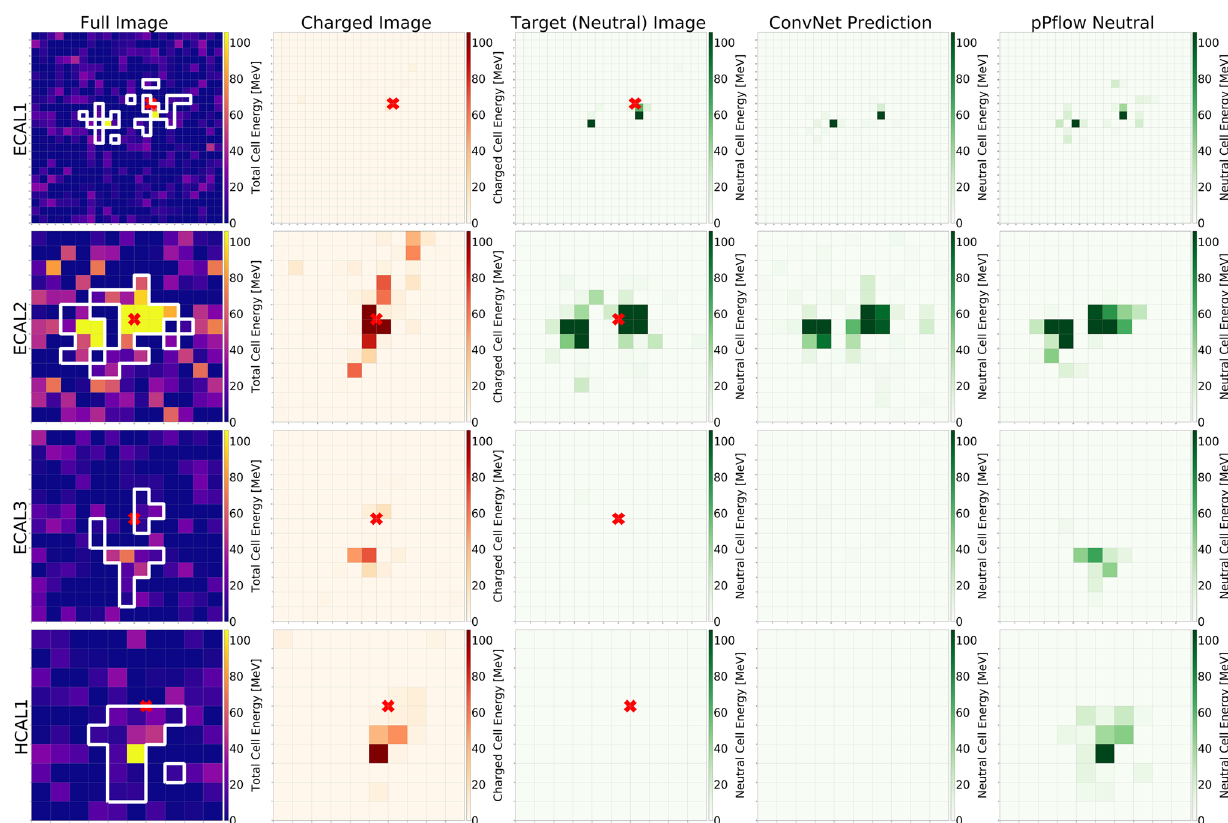
Fig. 3 Aneventdisplayshowingtheindividualcomponentsofcharged andneutralenergyperlayeralongwiththenoisedistributionforthefirst four calorimeter layers. The the extrapolated track position is shown by the red cross for the first three columns. The energy of the initial π + ,π 0 ranges between 2–5 GeV. The total energy also includes noise contribu- tion and topoclusters boundaries are outlined in white. The fourth and